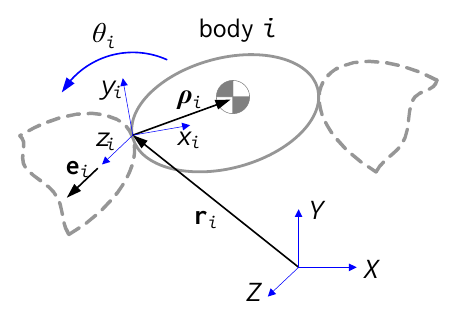
Figure 3: Mechanical model.